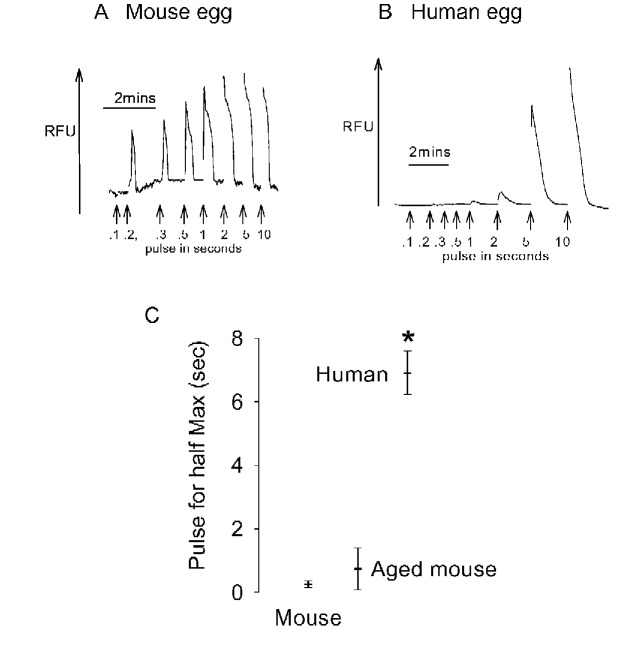

InsP3 induced Ca2+ release in CD1 mouse and human eggs using caged InsP3. (A) A typical recording where pulses of UV light of 100 ms (0.1 s) to 10 s were applied to a CD1 mouse egg injected with OGBD and caged 1,4,5-trisphophate (InsP3). Ca2+ increases are seen with all pulse durations over 200 ms. (B) A similar experiment except with a human egg. In this case, Ca2+ increases were only seen with UV pulses of greater than 2 s. We plotted the amplitude of each Ca2+ response against UV pulse duration to estimate the pulse duration that would have given a half maximal increase. The mean (horizontal line) and SD for the half maximal response is shown in (C) for human eggs (n = 14), fresh CD1 mouse eggs (n = 13) and aged CD1 mouse eggs (n = 8). (Note that the SD for fresh mouse eggs is small.) The differences between human eggs (*)compared to either fresh or aged mouse eggs are significantly different with P < 0.001. RFU, relative fluorescence units.